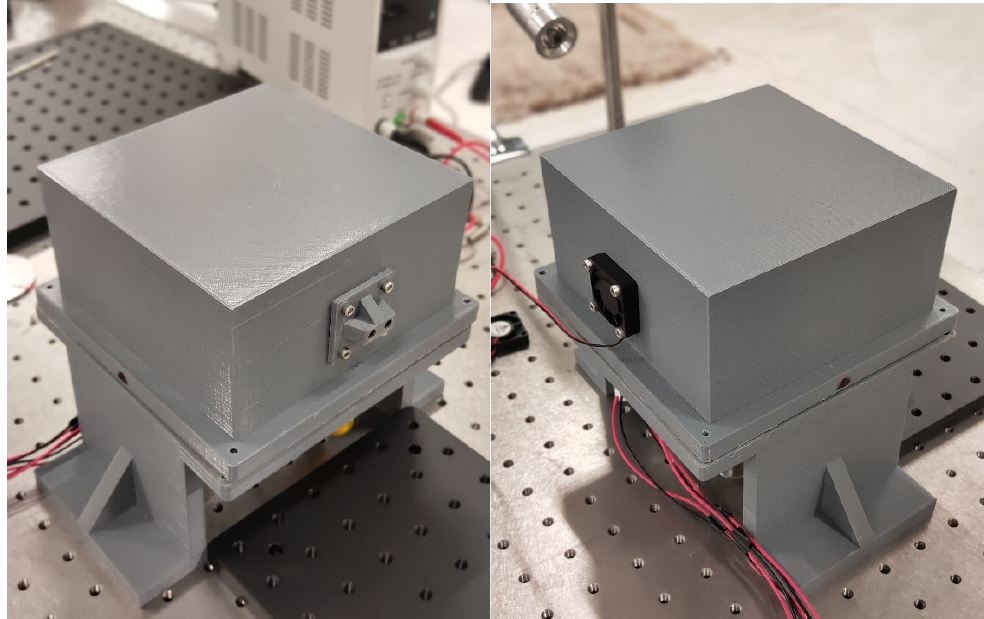
Figure 3. Illustration of the printed framework.